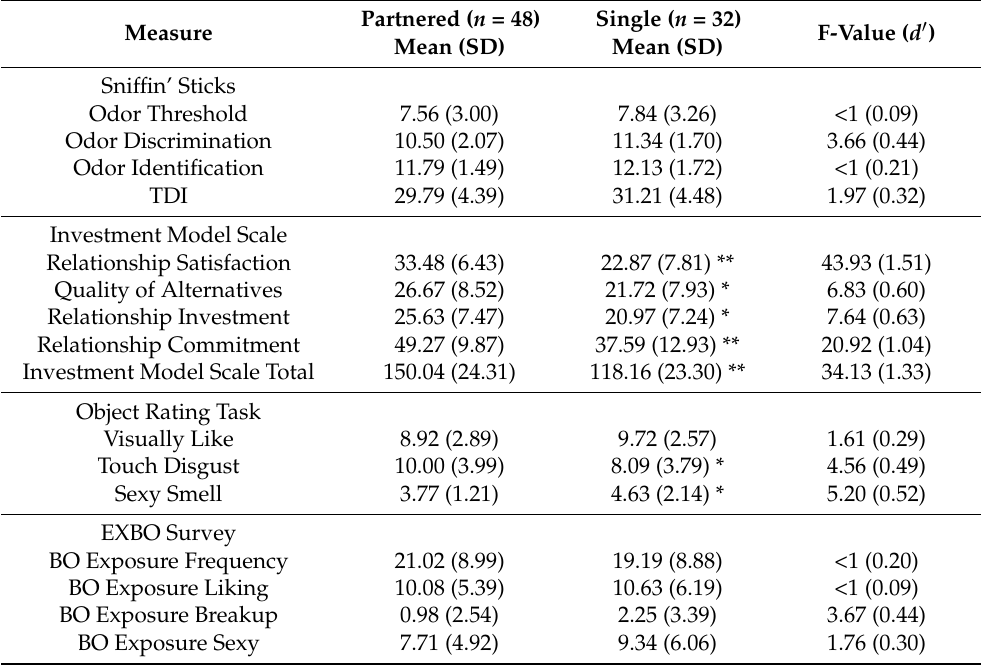
Table 1. Descriptive statistics and comparisons of Sniffin’ Sticks, IMS, ORT, and EXBO scores by relationship status.